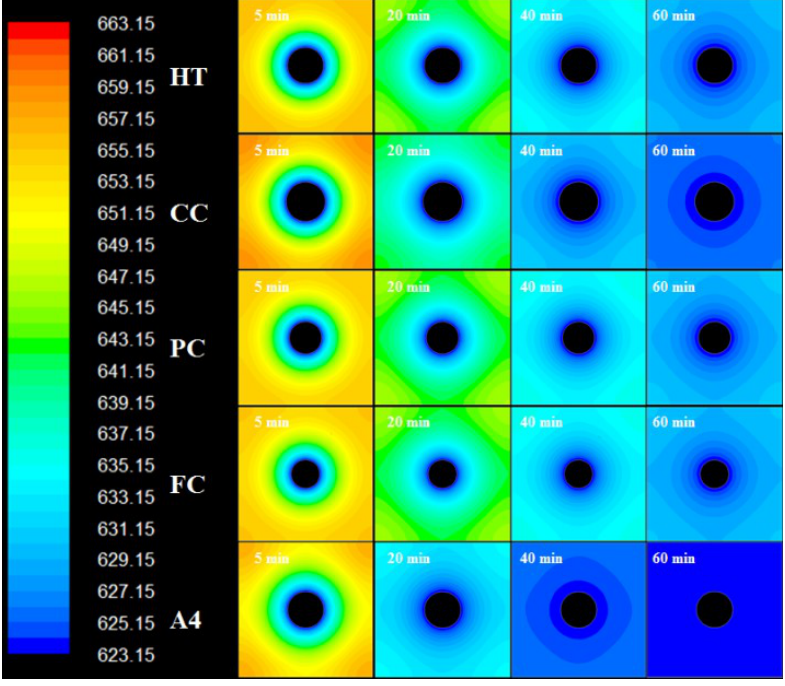
Figure 10. Temperature contour maps at constant Q